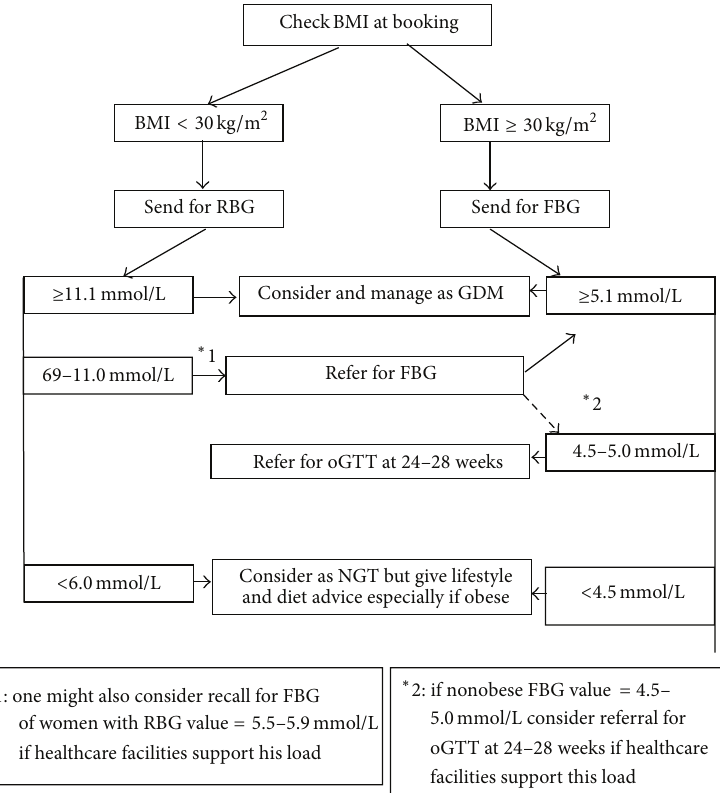
Figure 1: GDM screening flowchart based on BMI at booking and RBG/FBG